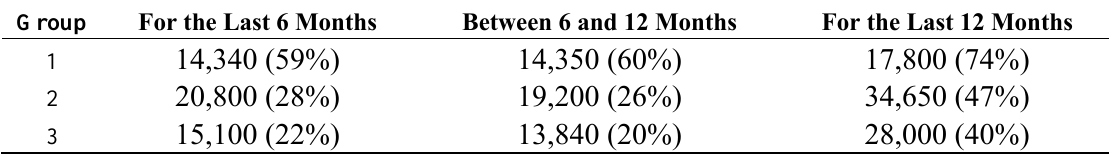
Table 2. Number of active members of the last six and 12 months (absolute and relative values). Group For the Last 6 Months Between 6 and 12 Months For the Last 12